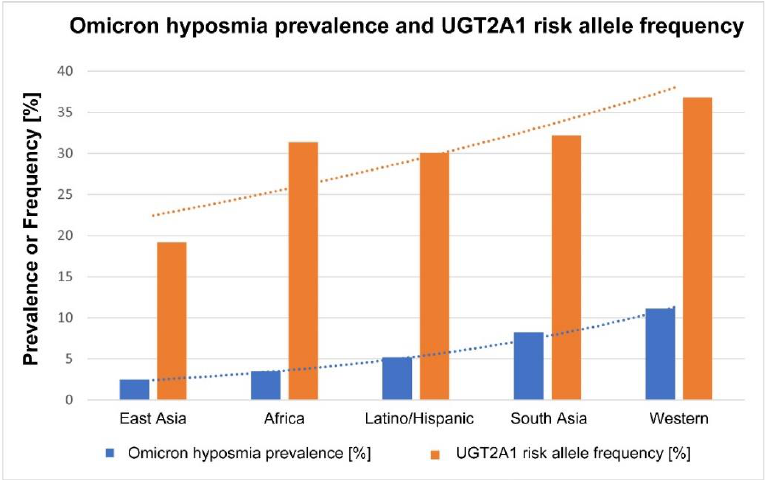
Figure 7. The bar graph shows the differences between ethnicities regarding omicron-induced prevalence of olfactory dysfunction (blue bars) compared with the frequency of the risk allele for olfactory dysfunction in the UGT2A1 locus according to Shelton et al., 2022 [13] (orange bars). The blue bars show the pooled estimates for the hyposmia prevalence among the same ethnicities according to our systematic review. Meta regression shows that there is a positive association between the two parameters ( p < 0.001): the prevalence of olfactory dysfunction is higher in those ethnic populations that have a higher frequency of the risk allele. The two exponential trend lines show this similarity.